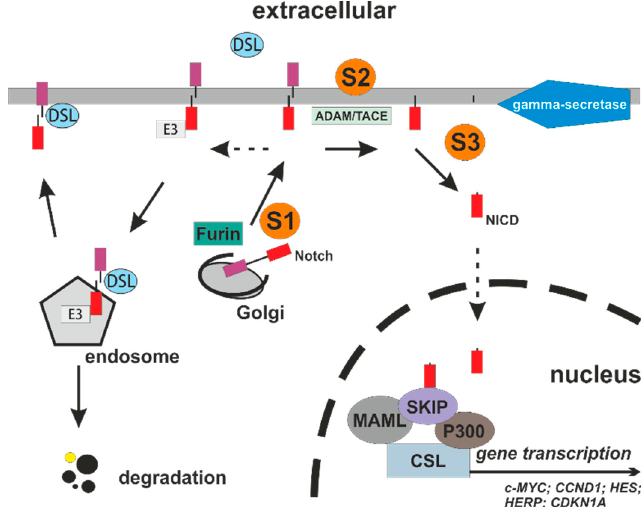
Figure 2. Canonical Notch signaling pathway. After (S1) cleavage by furin or furin-like convertases the heterodimeric Notch receptor translocates to the cell membrane. Right: Following ligand binding, proteolytic cleavage mediated by ADAM/TACE results in the release of NEC (S2) and additional cleavage at the transmembrane region by the γ -secretase complex creates the NICD (S3), which is able to translocate into the nucleus with subsequent activation of gene transcription. Left: Alternatively, after ubiquitination by E3-ligases, internalization of Notch to endosomes is possible. From endosomes, Notch can be recycled to the plasma membrane, pooled by cis-inhibition by DSL or degraded in the lysosome. ADAM/TACE: metalloproteinase containing protein; CSL: C-promoter binding factor-1 (CBF1 in humans, also known as CSL); DSL: Delta/Serrate Ligand; E3: E3-ligases; MAML: mastermind-like; NEC: Notch extracellular; NICD: Notch intracellular domain; SKIP: Ski-interacting protein.